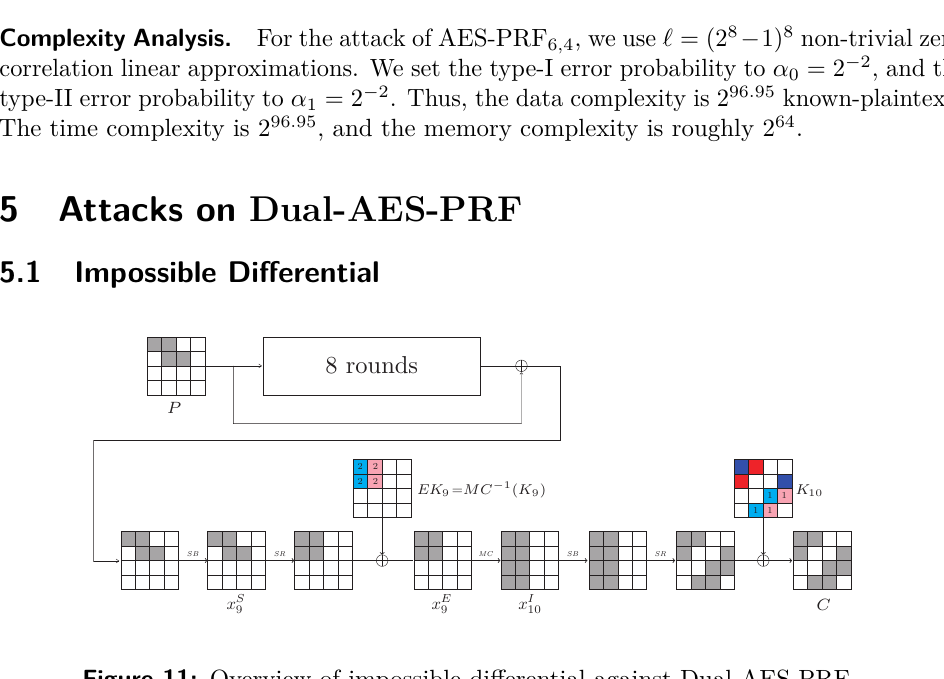
Figure 11: Overview of impossible differential against Dual-AES-PRF 8 , 2